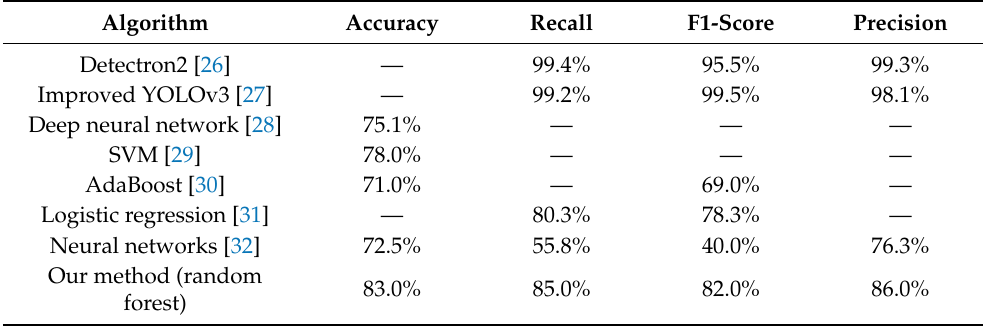
Table 6. Comparison of the performance achieved by the proposed model with existing research.